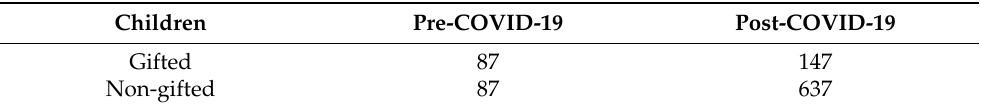
Table 1. Participants in the study. Children Pre-COVID-19 Gifted